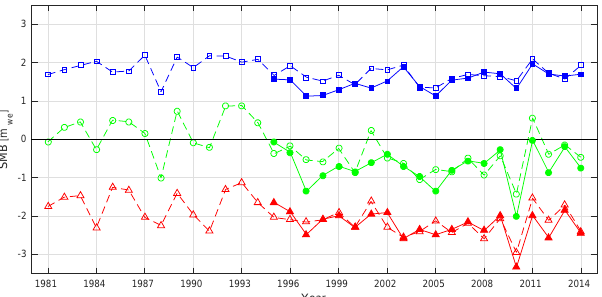
Figure 11. Same as Fig. 10, but corrected at the Öræfajökull area by reducing the HIRHAM5 simulated winter balance with 50%.